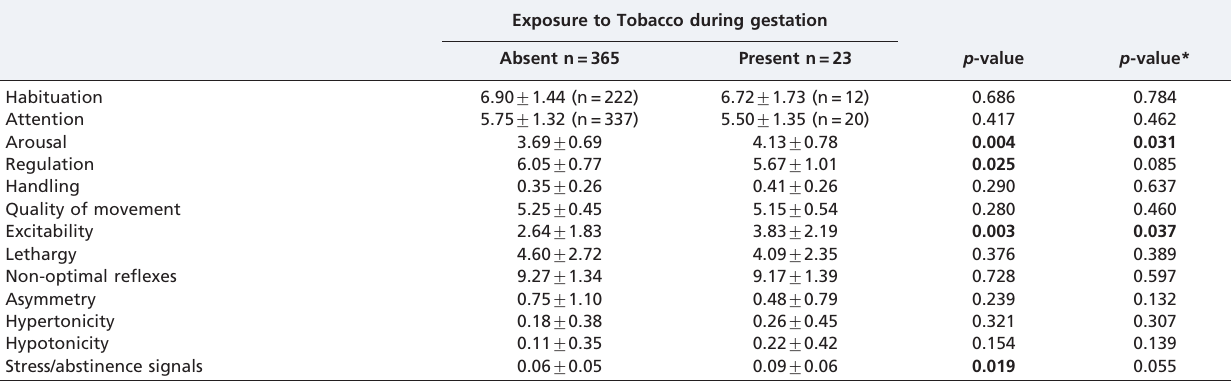
Table 3 - NNNS scores in the studied